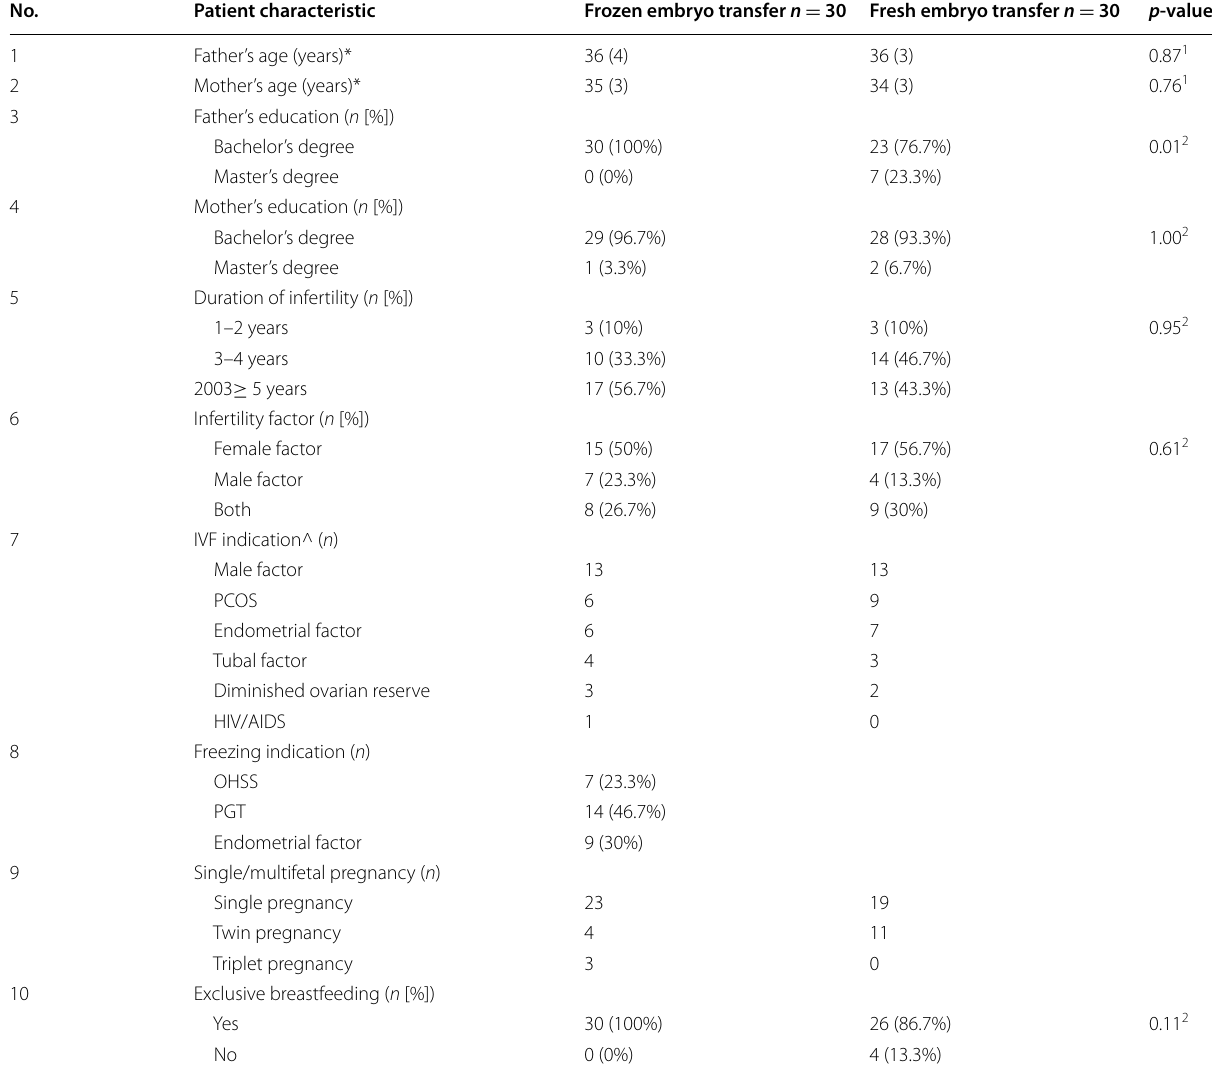
Table 1 Participants’